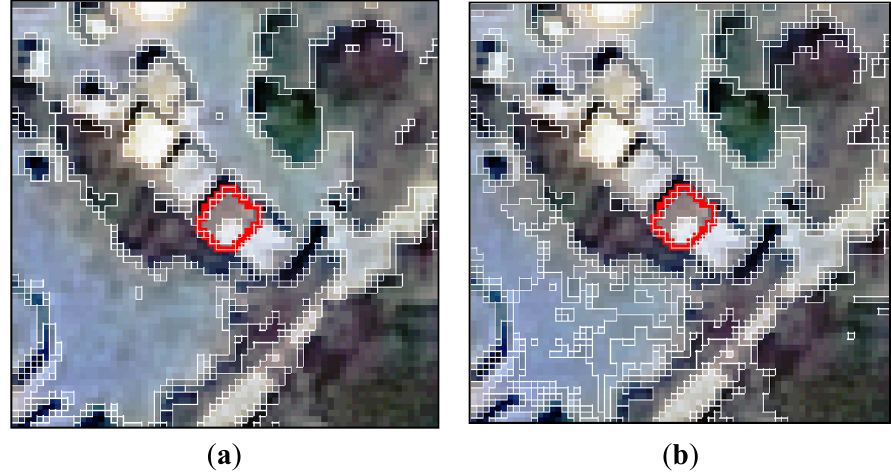
Figure 6. An image subset segmented with the local range parameter set to 50 and the global range parameter set to 200. Additional constraining attributes are introduced, specifically area, with a value of 800 ( a ) and CH1 ( b ) with a value of